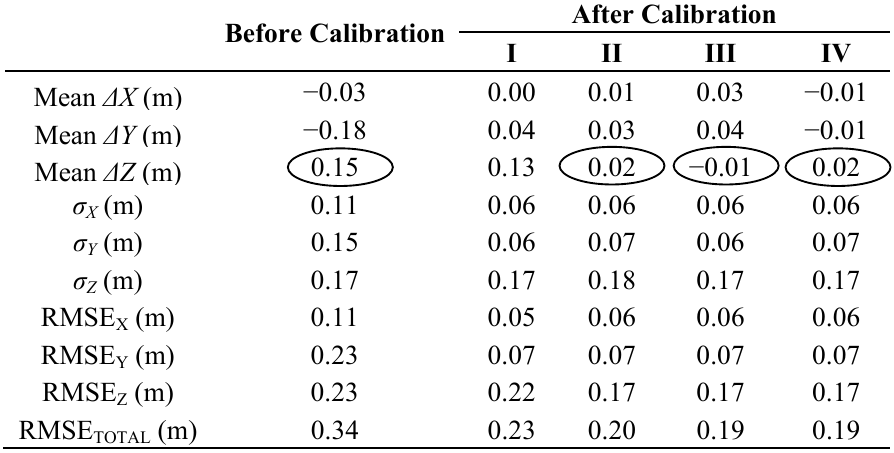
Table 4. RMSE analysis of the photogrammetric check points using extracted control linear features from the LiDAR data before and after the calibration